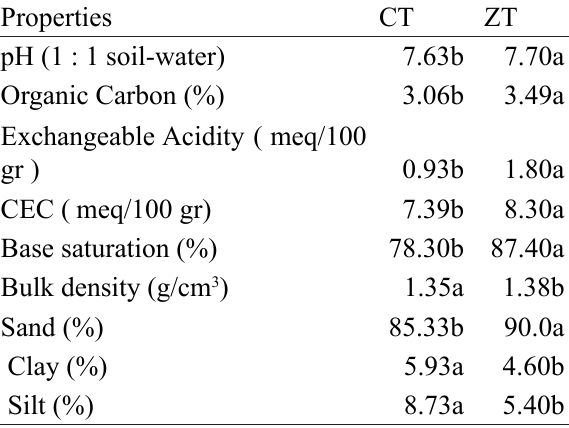
Table 3: Soil Properties during Late Season